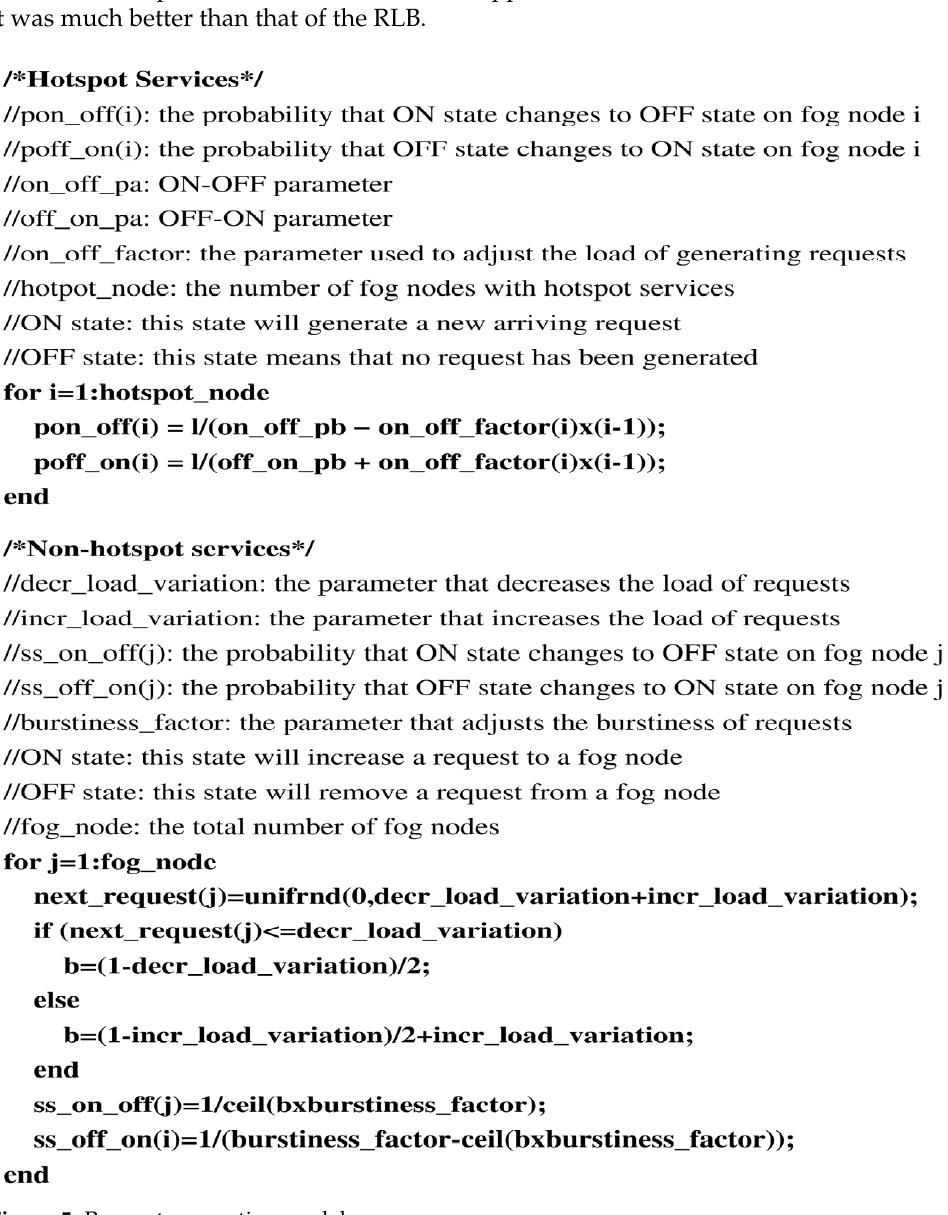
Figure 5. Request-generating models.